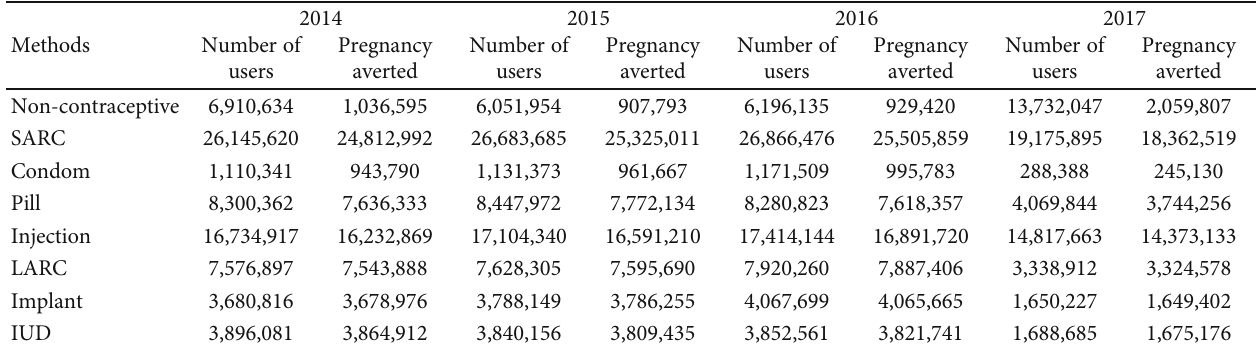
(a) Total number of contraceptive user and pregnancy averted in 2014-2017